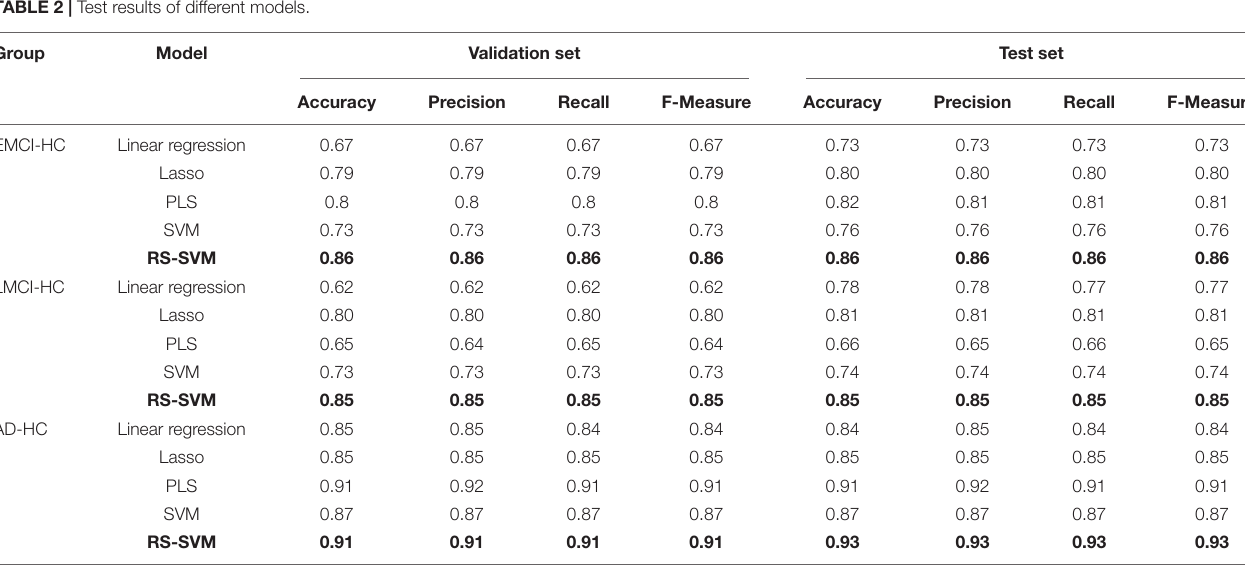
TABLE 2 | Test results of different